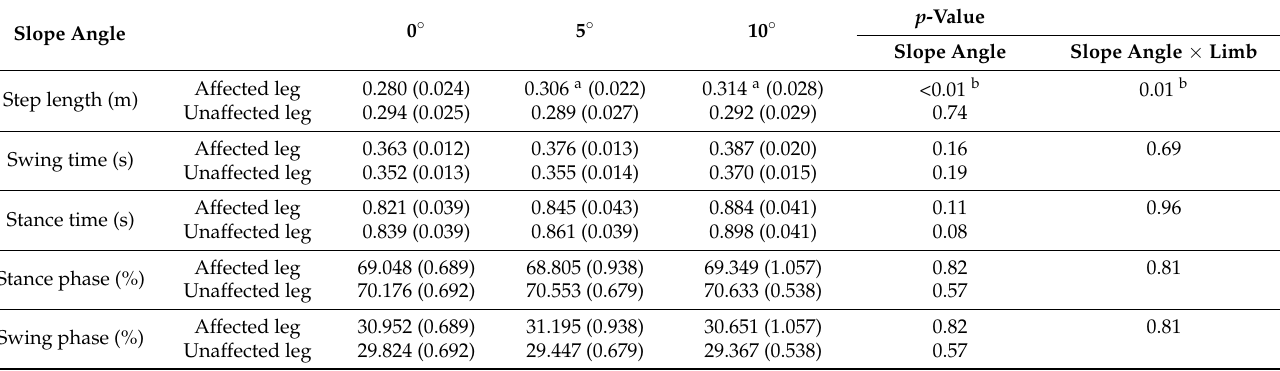
Table 2. Results of temporospatial parameters for both limbs during uphill